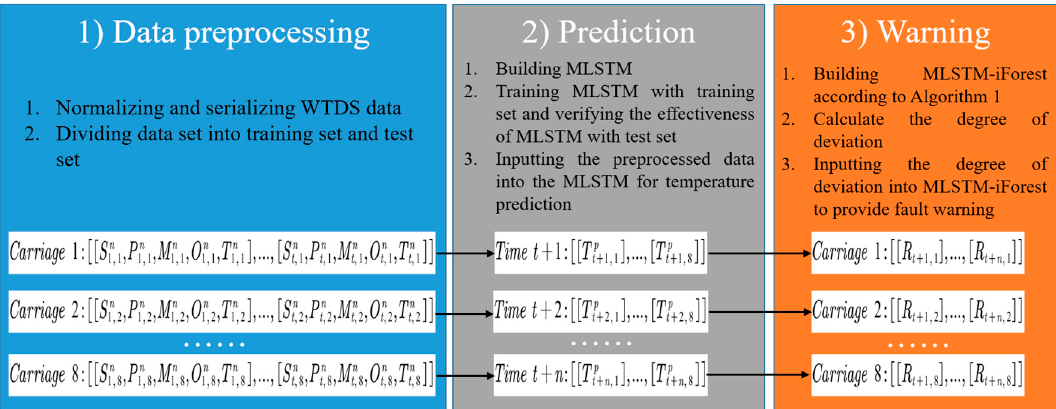
Figure 9. The flow chart of MLSTM-iForest. WTDS: Wireless transmit device system.